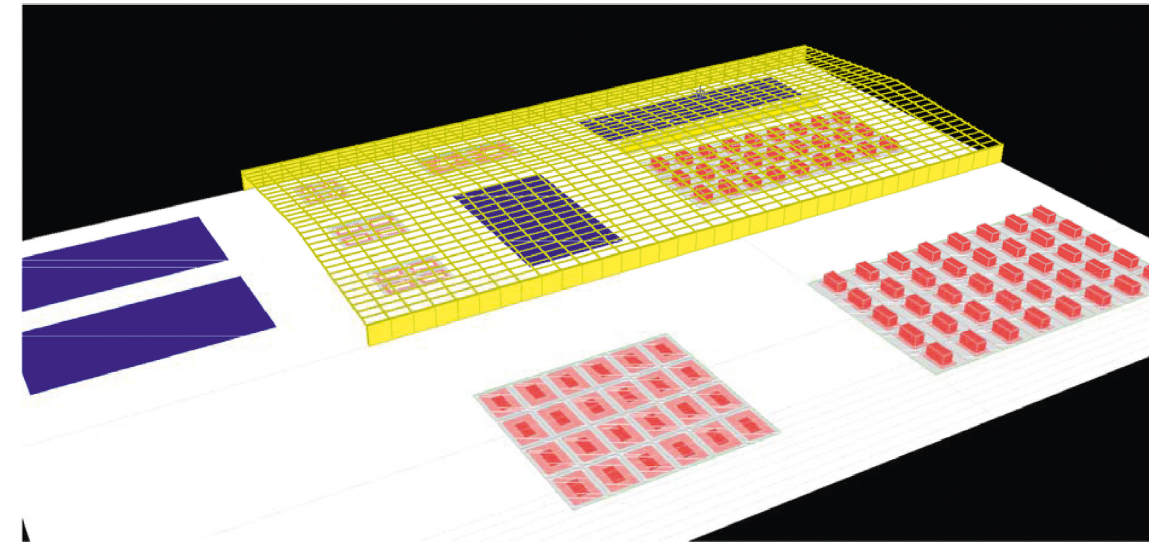
Figure 9: Simulation setup. Table 2: Productivity comparison between existing process and optimized